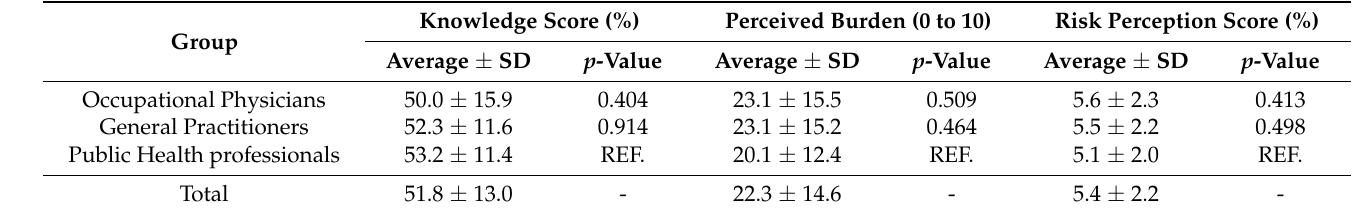
Table A2. Comparison of knowledge score, Risk Perception Score, Perceived Burden by occupational groups. The analyses were performed by means of Kruskal–Wallis test for multiple comparisons (the reference group was identified in Public Health Professionals).